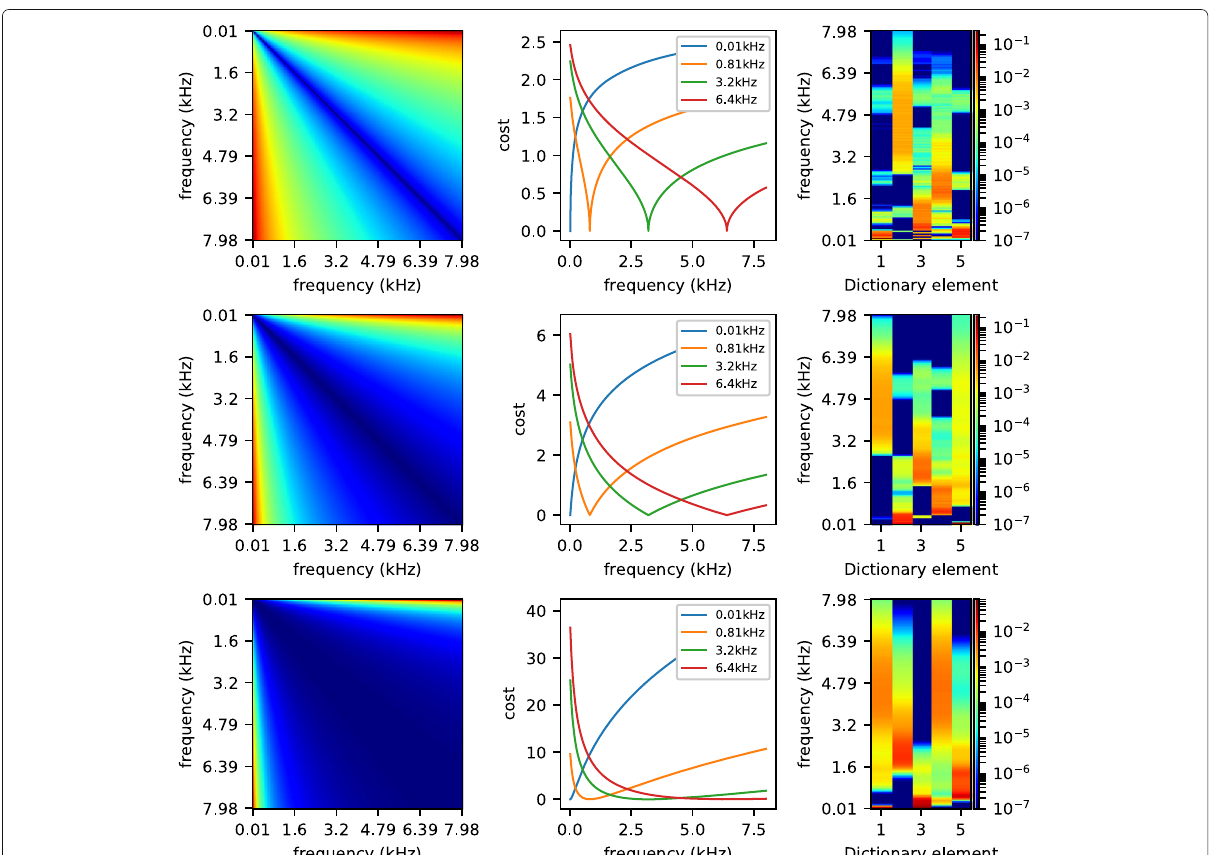
Fig. 3 Influence of the power p of the cost matrix. Left, cost matrix; center, sample lines of the cost matrix; right, dictionary learned on the validation data. Top , p = 0.5; center, p = 1; bottom, p = 2